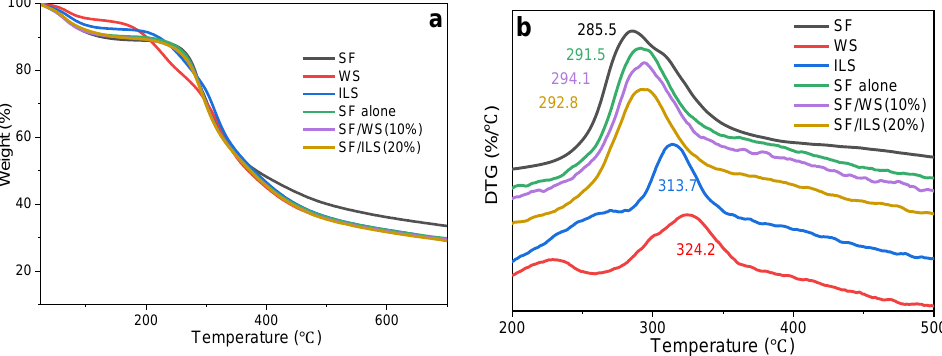
Figure 8. Thermal analysis TG ( a ) and DTG ( b ) of SF, WS, and ILS and pure SF scaffolds and SP composite scaffolds.